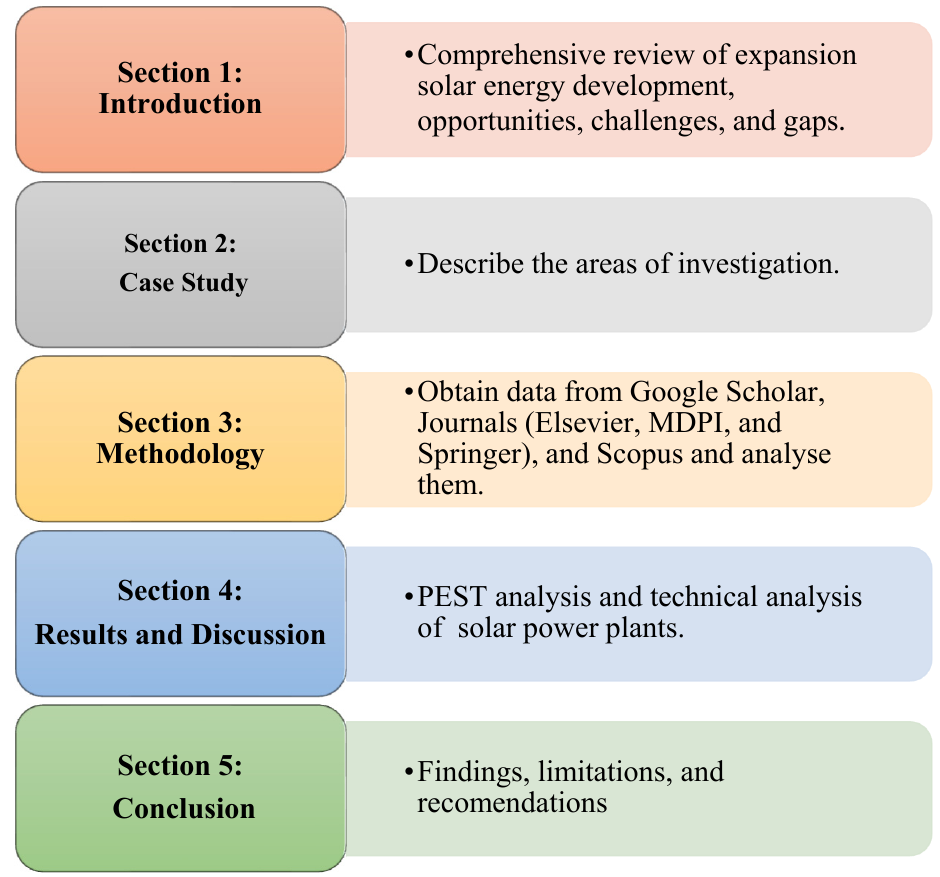
Figure 3. Research Methodology.